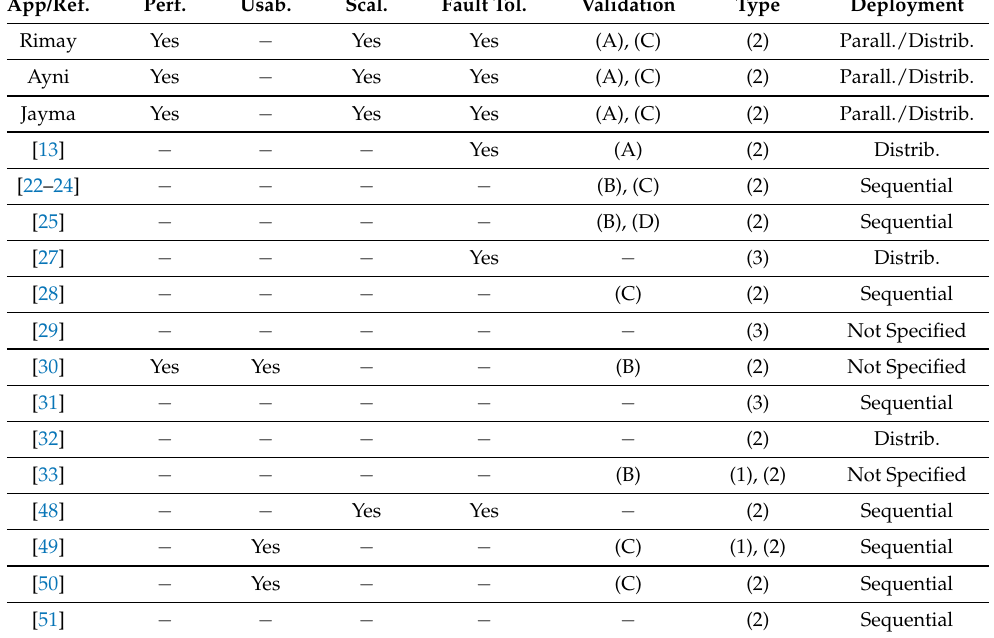
Table 4. Main features presented by Ayni, Rimay, Jayma, and other applications presented in the technical literature. In the column Validation, we use the letter (A) if the experiments were performed on a real system, (B) with simulations and/or (D) with synthetic data. (C) indicates whether the application was validated by experts. In the column Type, we use the number (1) to indicate that a guideline is presented, (2) for applications or simulators that have been implemented, and (3) for papers presenting a model or proposal not actually